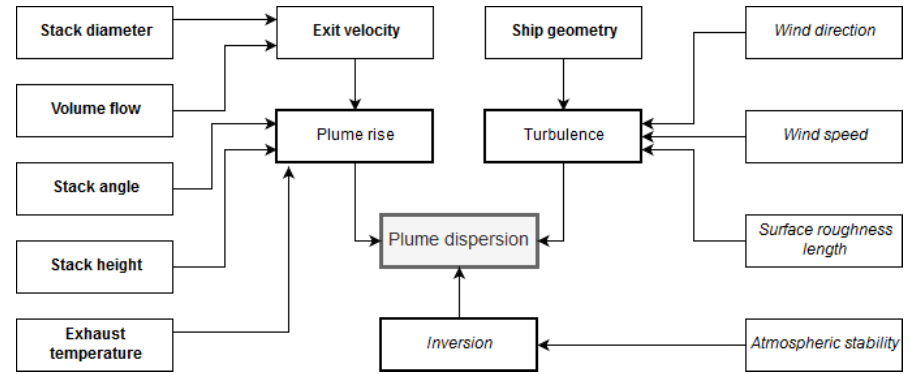
Figure 1. Conceptual model of parameters affecting the shape and movement of a ship plume (bold text indicates technical parameters; italic indicates ambient parameters).